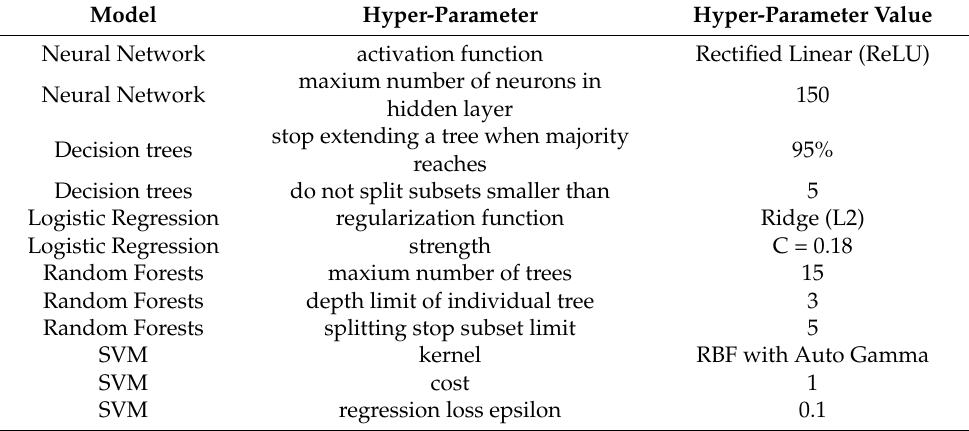
Table 3. Values of classification model